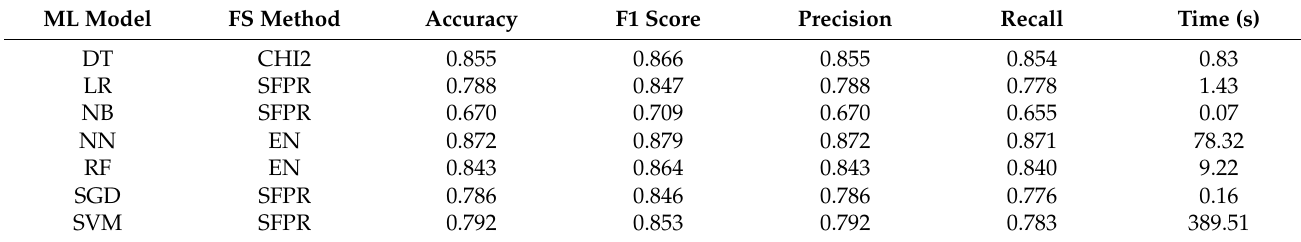
Table 8. Individual machine learning model best performance